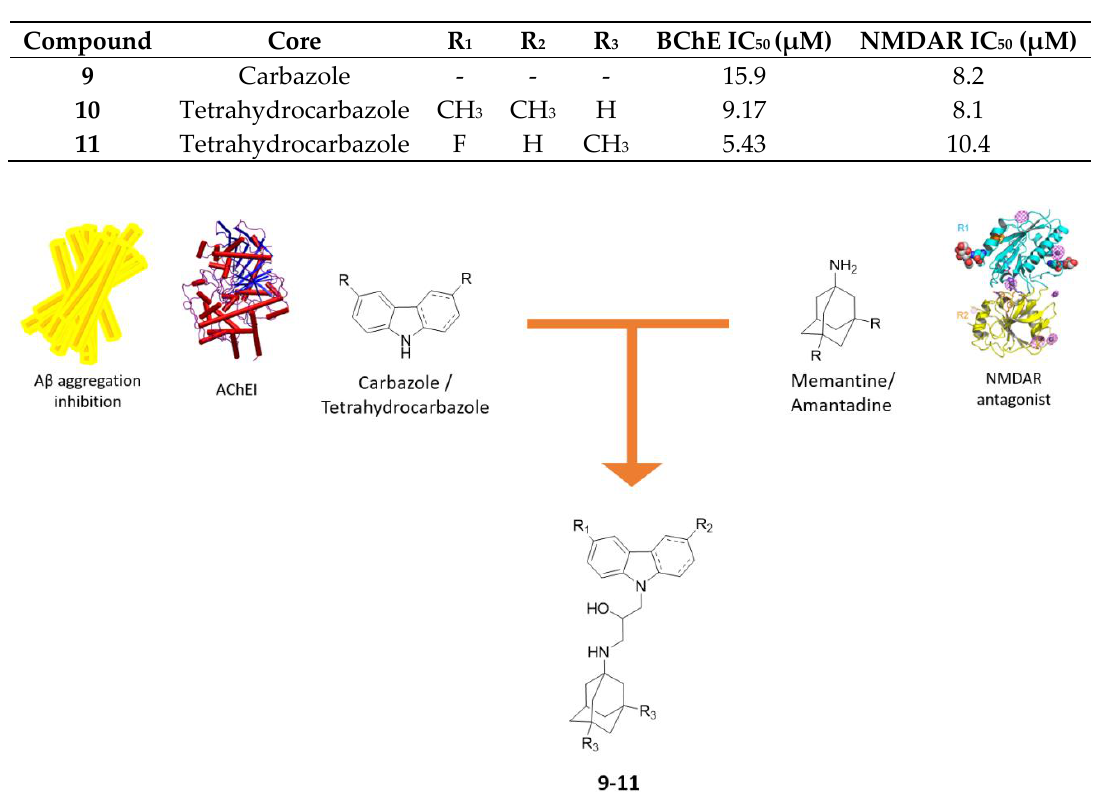
Figure 6. Drug design and biological activities of carbazole / tetrahydrocarbazole-aminoadamantane hybrids 9 – 11 .